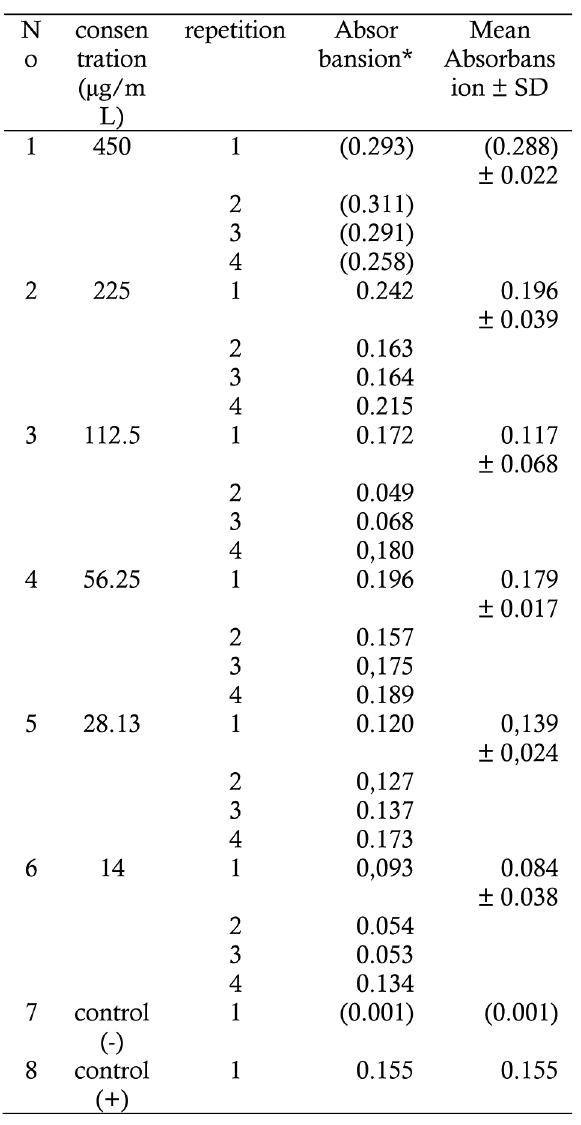
was performed by broth dilution method using a Mueller Hinton Broth (MHB) media -mangostin α concentration range 14-450 µg/mL. the absorbtion after the treatment on uropathogenic E.coli is shown as follows; Table 3. Mean ± SD difference (decrease/increase) in absorbance after treatment α - mangostin on uropathogen E. coli in MHB media